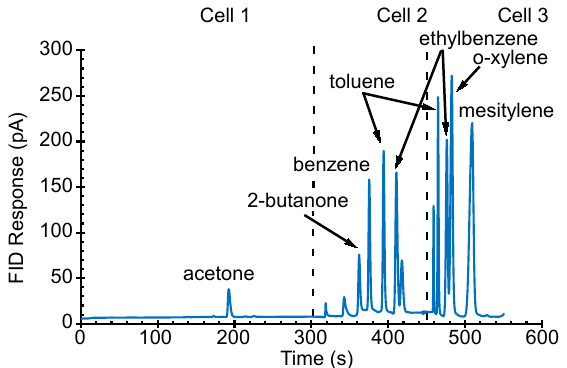
Figure 10. PCA3mv chromatogram of 30 min sampling of 200 ppb of aromatics. Acetone was separated in Cell 1, 2-butanone, benzene, toluene, and ethylbenzene were separated in Cell 2, and ethylbenzene, o-xylene, and mesitylene were separated in Cell